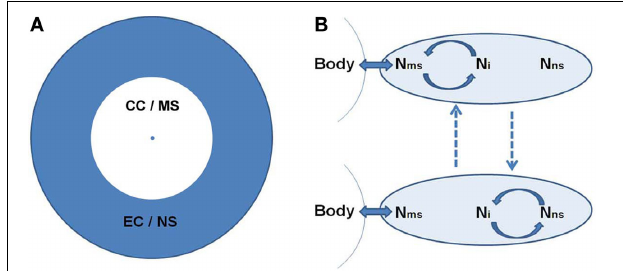
FIGURE 1 | (A) The concentric organization of the Consciousness State Space (CSS). The central point denotes the body. Around it is the core-consciousness (CC) and minimal-self (MS) sphere in white, surrounded by the extended-consciousness (EC) and the narrative-self (NS) sphere in gray. This circular organization depicts a shorter and longer psychological distance from the body for the CC/MS and EC/NS, respectively. (B) The suggested neural space, depicted as an oval. Within it we identify three main networks, two of them supporting the MS and NS (N ms and N ns , respectively), and the third interposed between them (N i ). The body’s condition becomes available to the neural space through N ms . Ni switches between synchronization (marked by circular arrows) with the two other networks. Dashed lines denote alternation between the neuronal states. The top state corresponds phenomenologically to CC/MS, and the bottom to EC/NS. For the suggested brain regions for each neural space see section A Dual Organization of Consciousness, Self, and Brain